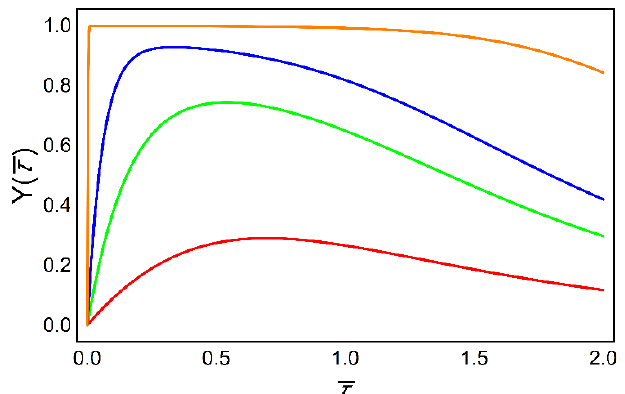
Figure 5. Calcium/calmodulin activation and inactivation increases with increasing amplitude of “Ca 2+ cloud spikes” ( ε = 1 red, ε = 1.5 green, ε = 2 blue, ε = 5 orange). The effective dimensionless time is now τ = vt ℓ𝑏 𝑌